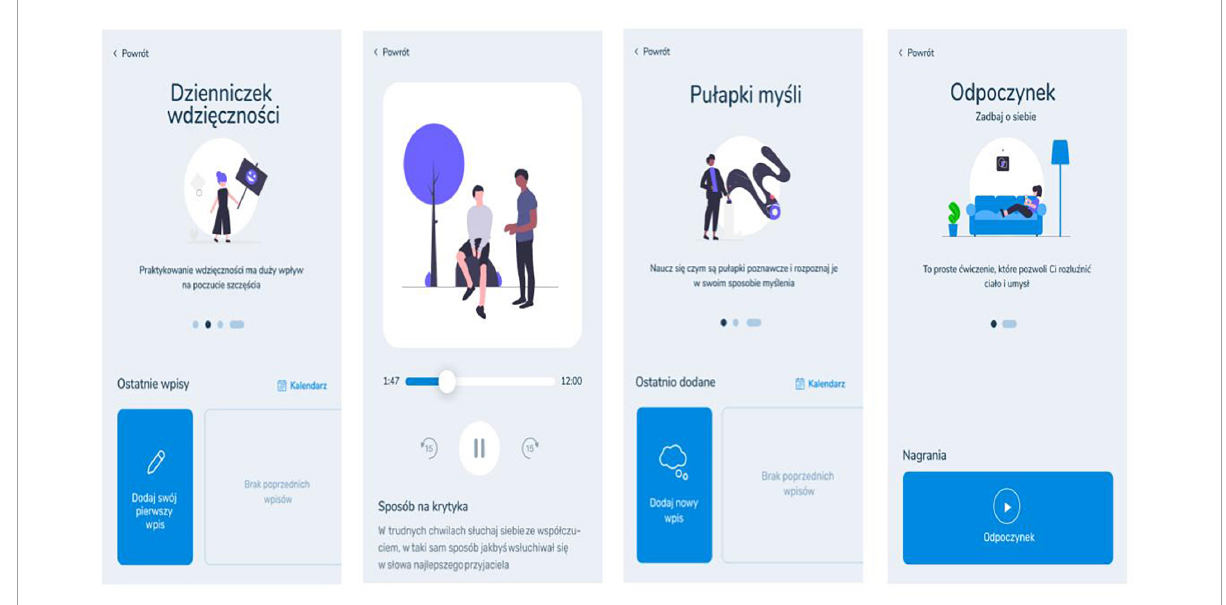
FIGURE2 Example screenshots of the self-guided intervention modules in Nałogometr